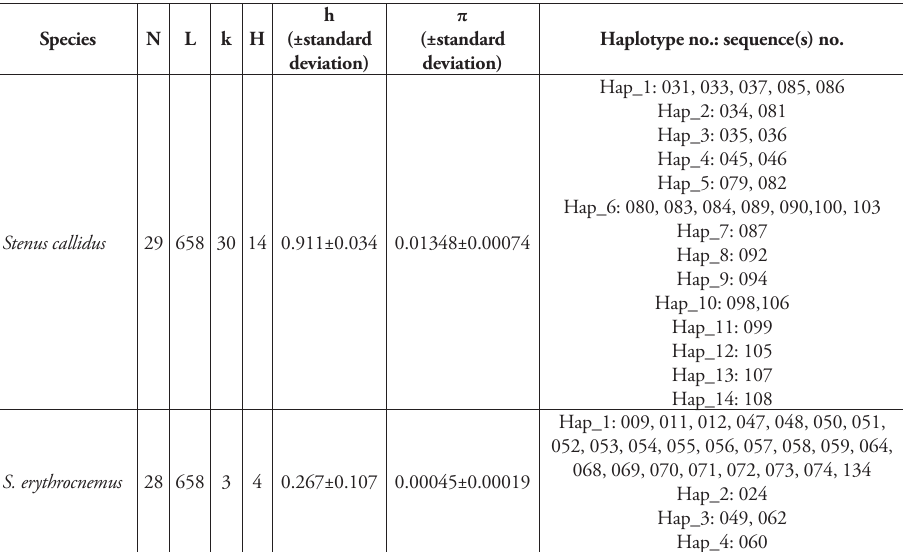
Table 4. Summary of genetic diversity indices in the mitochondrial COI gene segment of Stenus callidus and S. erythrocnemus